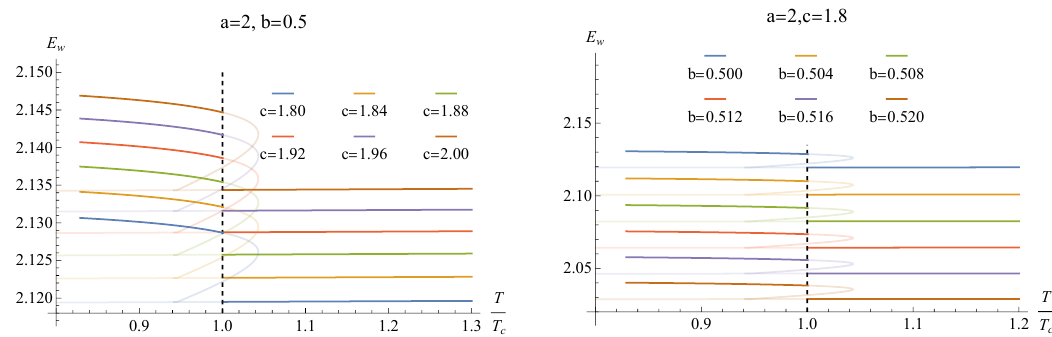
Figure 12 . The EWCS E w versus the temperature T/T c in the first-order phase transition. The dashed black line represents the critical temperature when T c ≈ 0 . 003382 . The translucent line represents the metastable state, whereas the solid line represents the stable state. Left plot: we set a = 2 and b = 0 . 5 with varying c values. Right plot: we set a = 2 and c = 1 . 8 while varying b values.